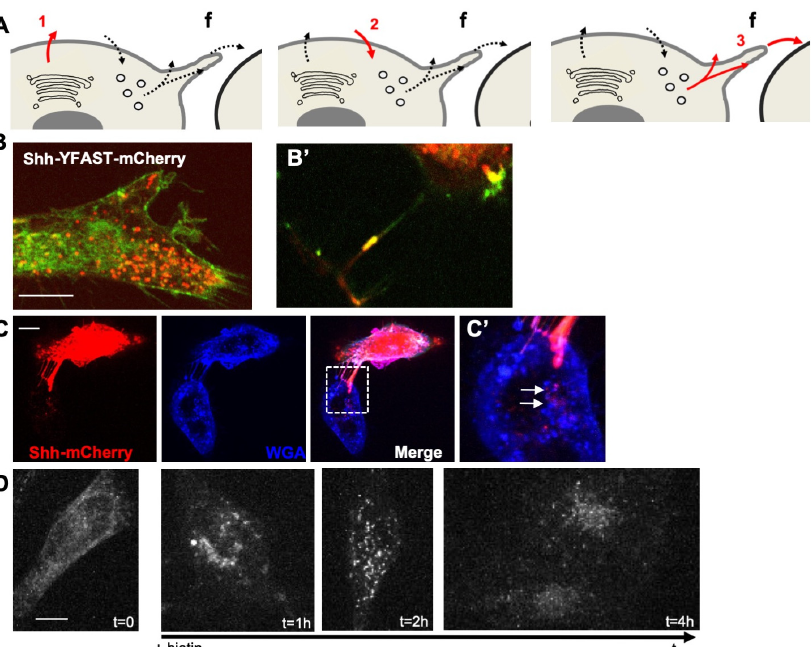
Figure 1. HeLa cells recapitulate typical events of Shh trafficking. ( A ) Schematic view of important steps analyzed in HeLa cells: (1) first secretion; (2) endocytosis; (3) dispatching to receiving cells; f: filopodium. ( B ) Double tagging with YFAST and mCherry allows the detection of Shh in three different compartments. Left panel: in a steady state, a cell producing Shh-YFAST-mCherry exhibits both a diffuse green signal (YFAST is detected early in the endoplasmic reticulum, when mCherry has not yet matured) and an abundant red vesicular signal (mCherry detected in the endosomes, where the pH prevents YFAST detection) and in filopodia where both tags are detected ( B’ ). ( C ) In co-culture, pairs of Shh-producing (mCherry signal) and non-producing cells (both decorated by the binding of the WGA lectin to cell coat) often display filopodia between them. Large red dots in the non-producing cell indicate Shh transfer to recipient cells, and their position suggests delivery via the filopodia (white arrows in the enlarged inset in ( C’ )). ( D ) Shh-Sbp-mCherry secretion synchronized with the RUSH system displays classic timing: Shh is correctly hooked in the endoplasmic reticulum before biotin addition, reaches the Golgi 30–40 min after biotin addition, is secreted at approximately 1 h, can be easily detected within endosomes of the producing cell at 2 h, and can be visualized in non-producing cells at 4 h. Scale bars, 10 μ m.